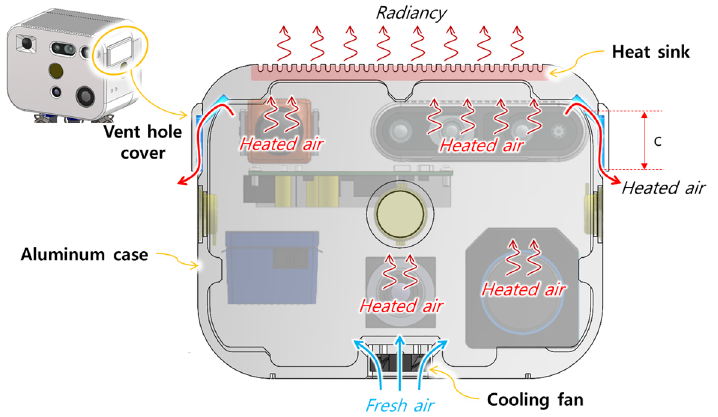
Figure 5. Measures about heat exhaust and